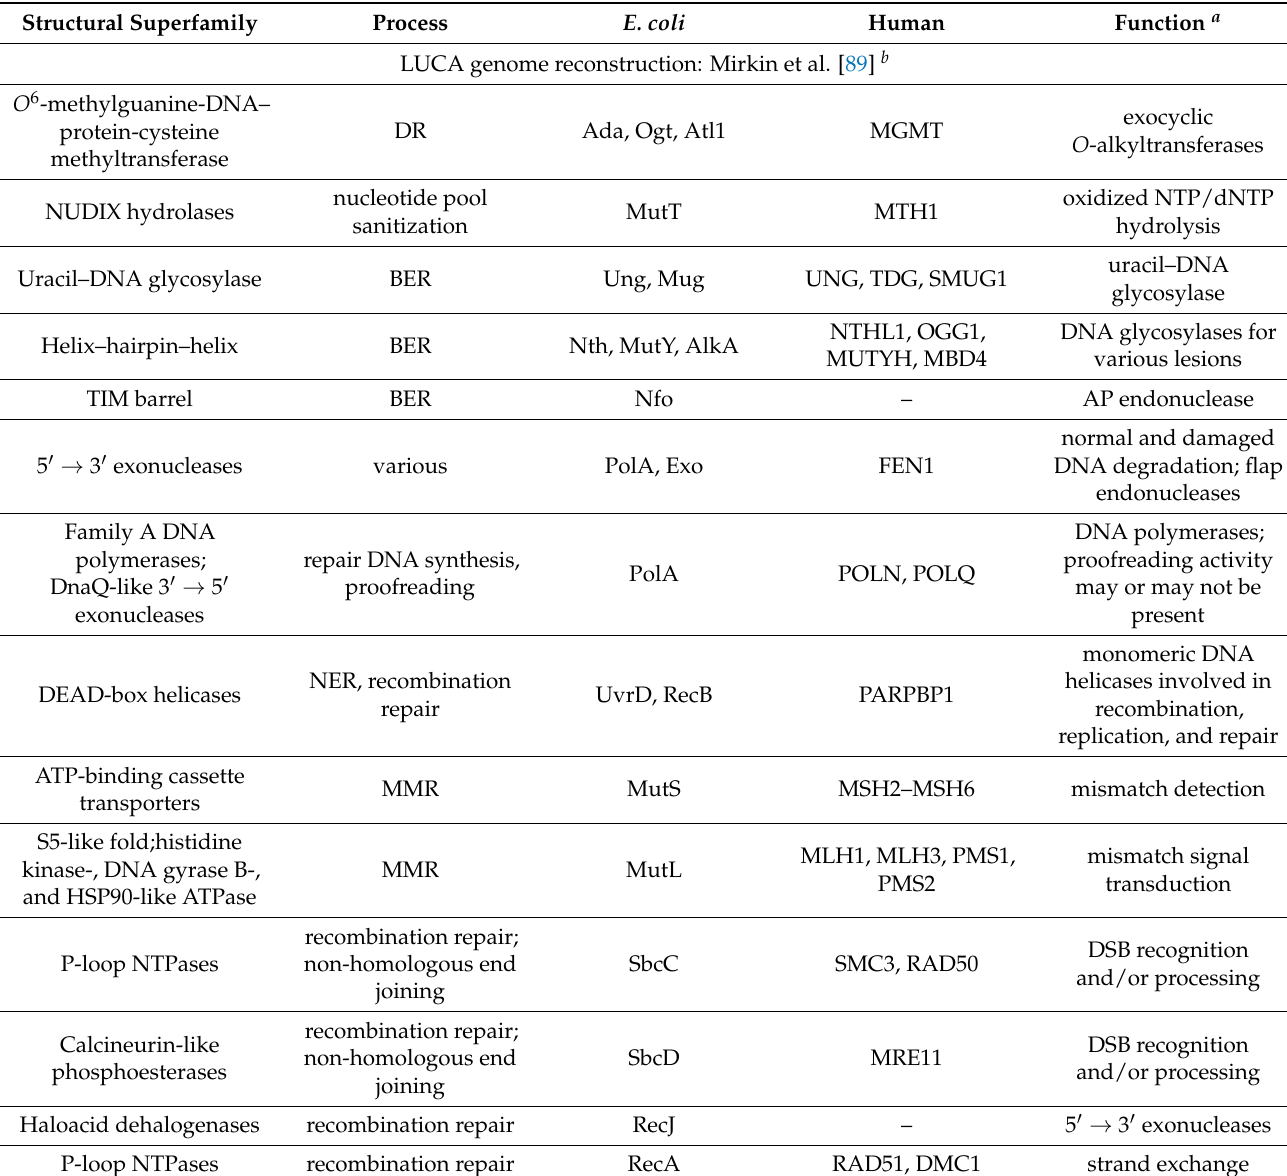
Table 1. DNA repair protein-coding genes from reconstructed and minimal genomes. Structural